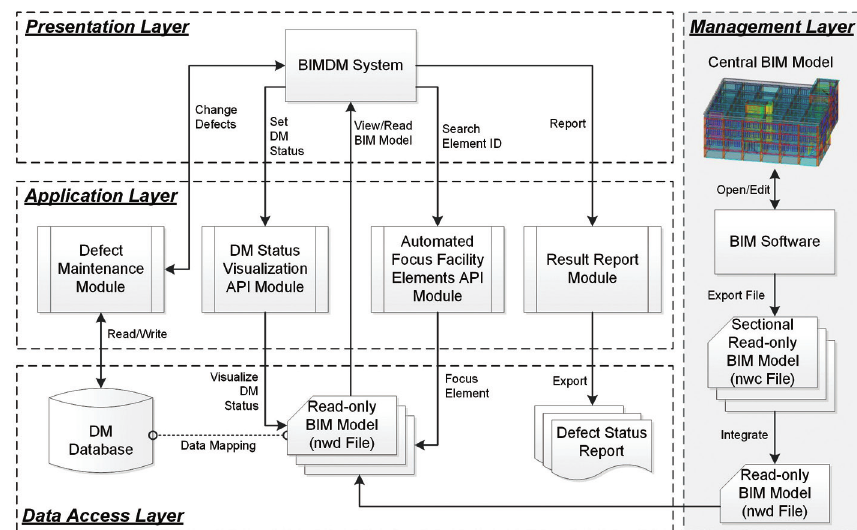
Fig. 4. System and modules framework of the BIMDM